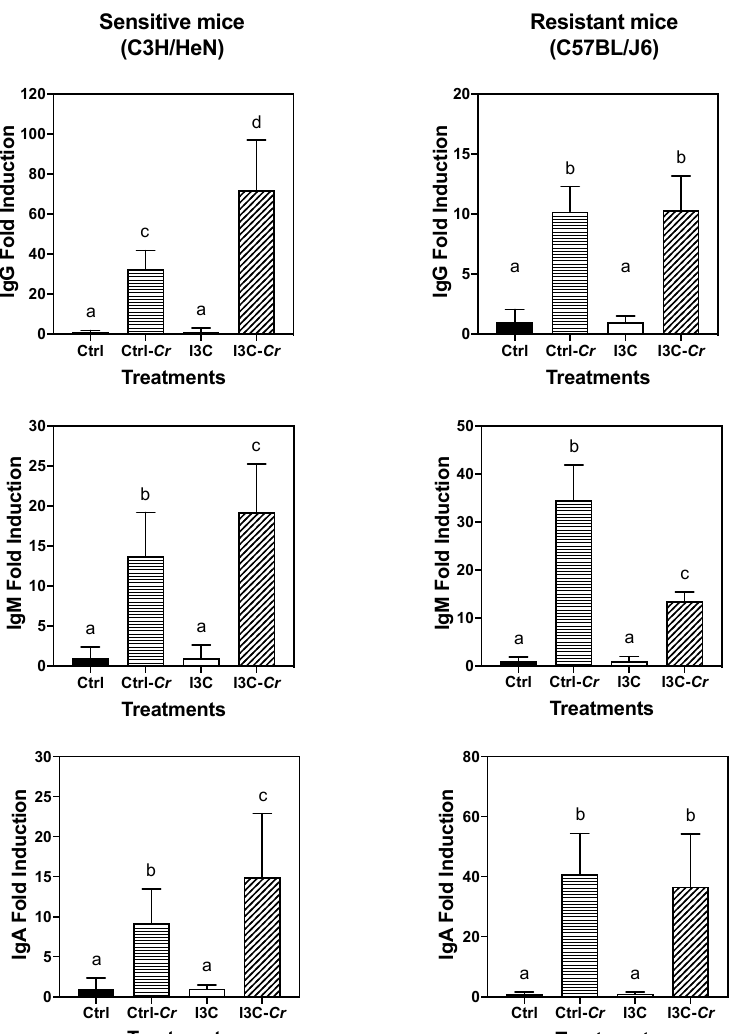
Figure 9. Effects of I3C on Cr-induced IgG response in sensitive (C3H/HeN) and resistant (C57BL/J6) mice. Cr-specific serum antibody levels were calculated as fold change between uninfected controls and infected mice on each diet. Results expressed as the mean+/-SD fold-change (n = 8). Ctrl: control diet; Ctrl-Cr: control diet, Cr-infected; I3C: I3C diet; I3C-Cr: I3C diet, Cr-infected. Significant differences ( p < 0.05) between groups are identified by different letters.